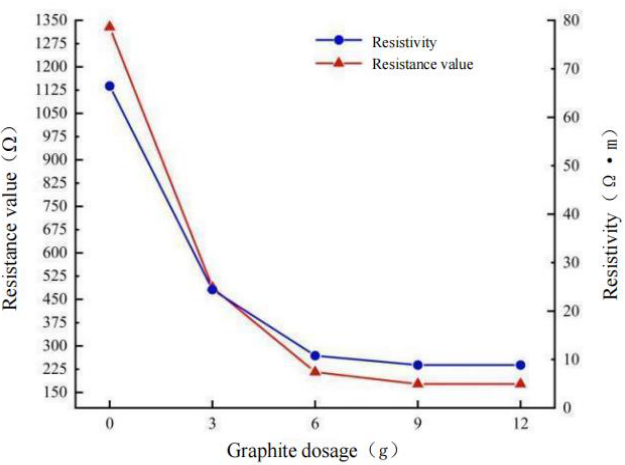
Figure 17. Diagram showing resistance variation trend of specimen.